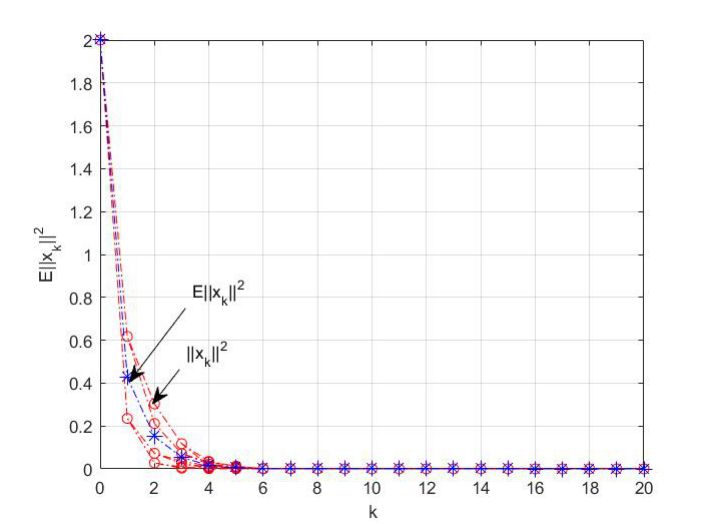
Figure 3. The norm E (cid:107) x k (cid:107) 2 curve of the closed-loop system state with respect to the iteration step k in Example